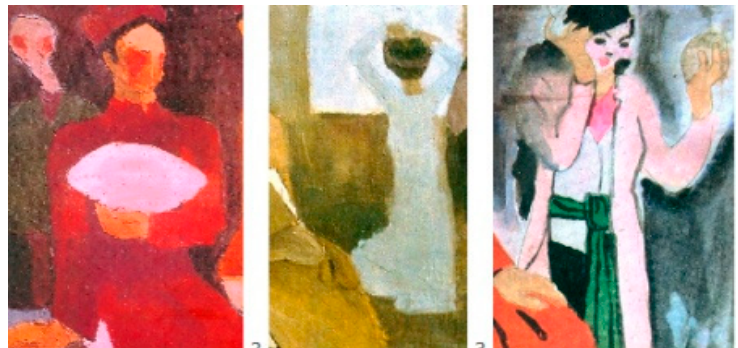
Figure A11. Where Cheo Actor supposedly copied from. The image was sourced from Thanh Nien Newspaper (Nguyen 2016a).